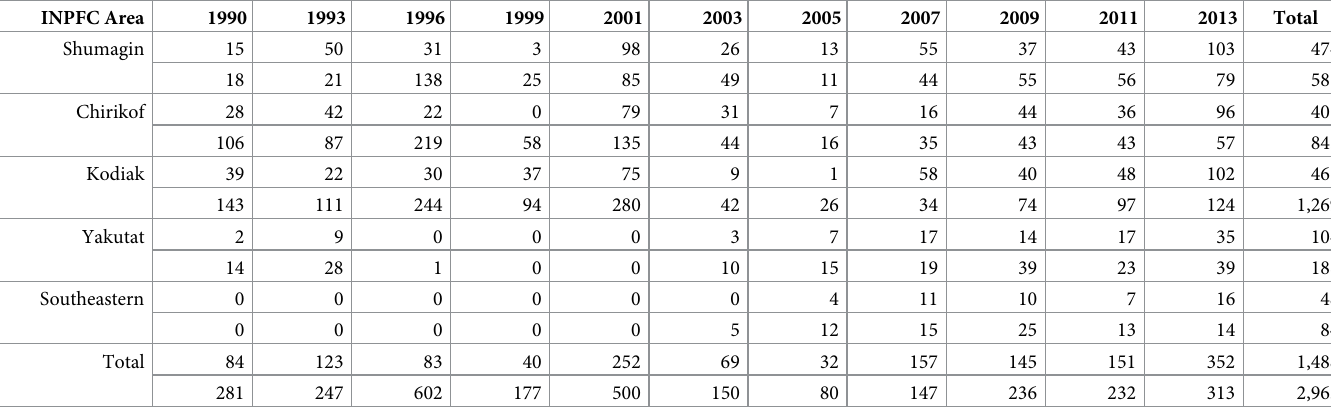
Numbers for Pacific Halibut are listed as the top line in each category and Arrowtooth Flounder are shown below. Food habits data were not yet available for 2015 or